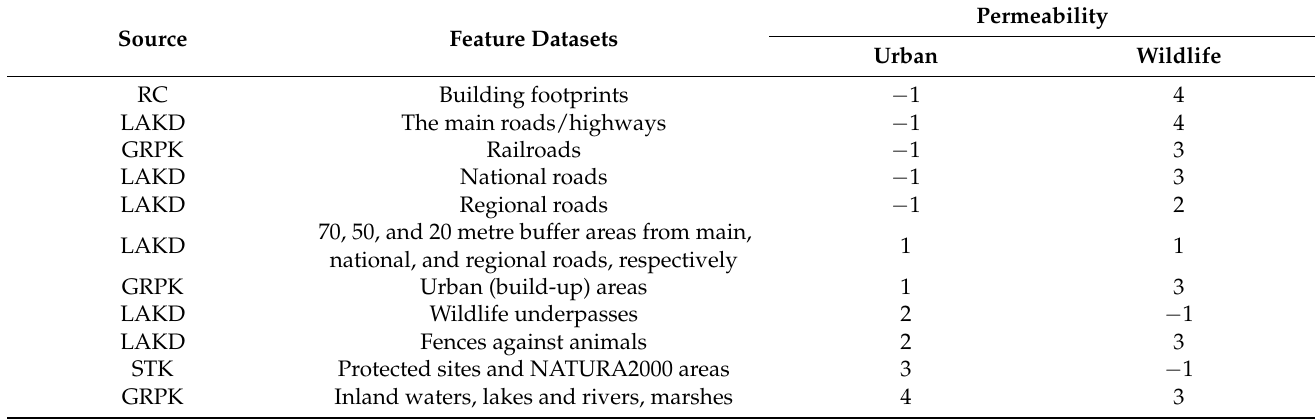
Table 3. List of land-cover/land-use permeability scores for different feature